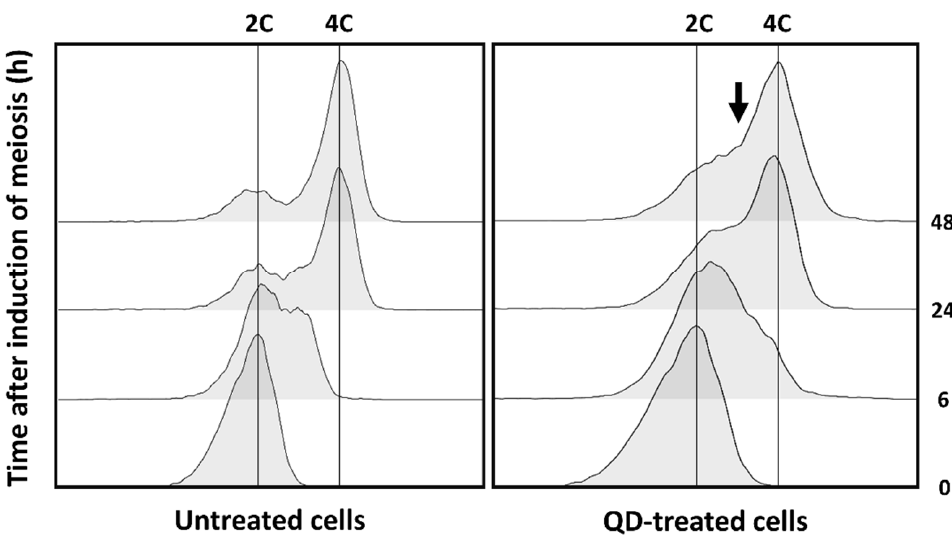
Figure 8. CdS QD treatment causes an alteration of the kinetic of meiotic-nuclear divisions during the sporulation process. DNA content determined by FC analysis in untreated cells and cells exposed to CdS QDs (5 mg L − 1 ) for different amounts of time (0–48 h) in sporulation medium are shown. The x -axis represents DNA content (per cell), and the y -axis represents the numbers of cells in each condition. A high percentage of cells with an aberrant DNA amount (between 2C and 4C) was observed even at prolonged times of CdS QD exposure (indicated with black arrow).